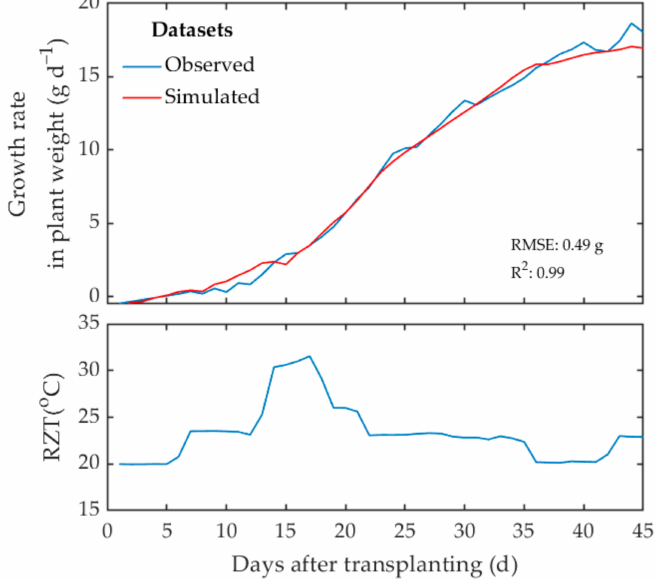
Figure 7. Comparison of the estimated response calculated by the developed neural network model and the observed growth rate of plant